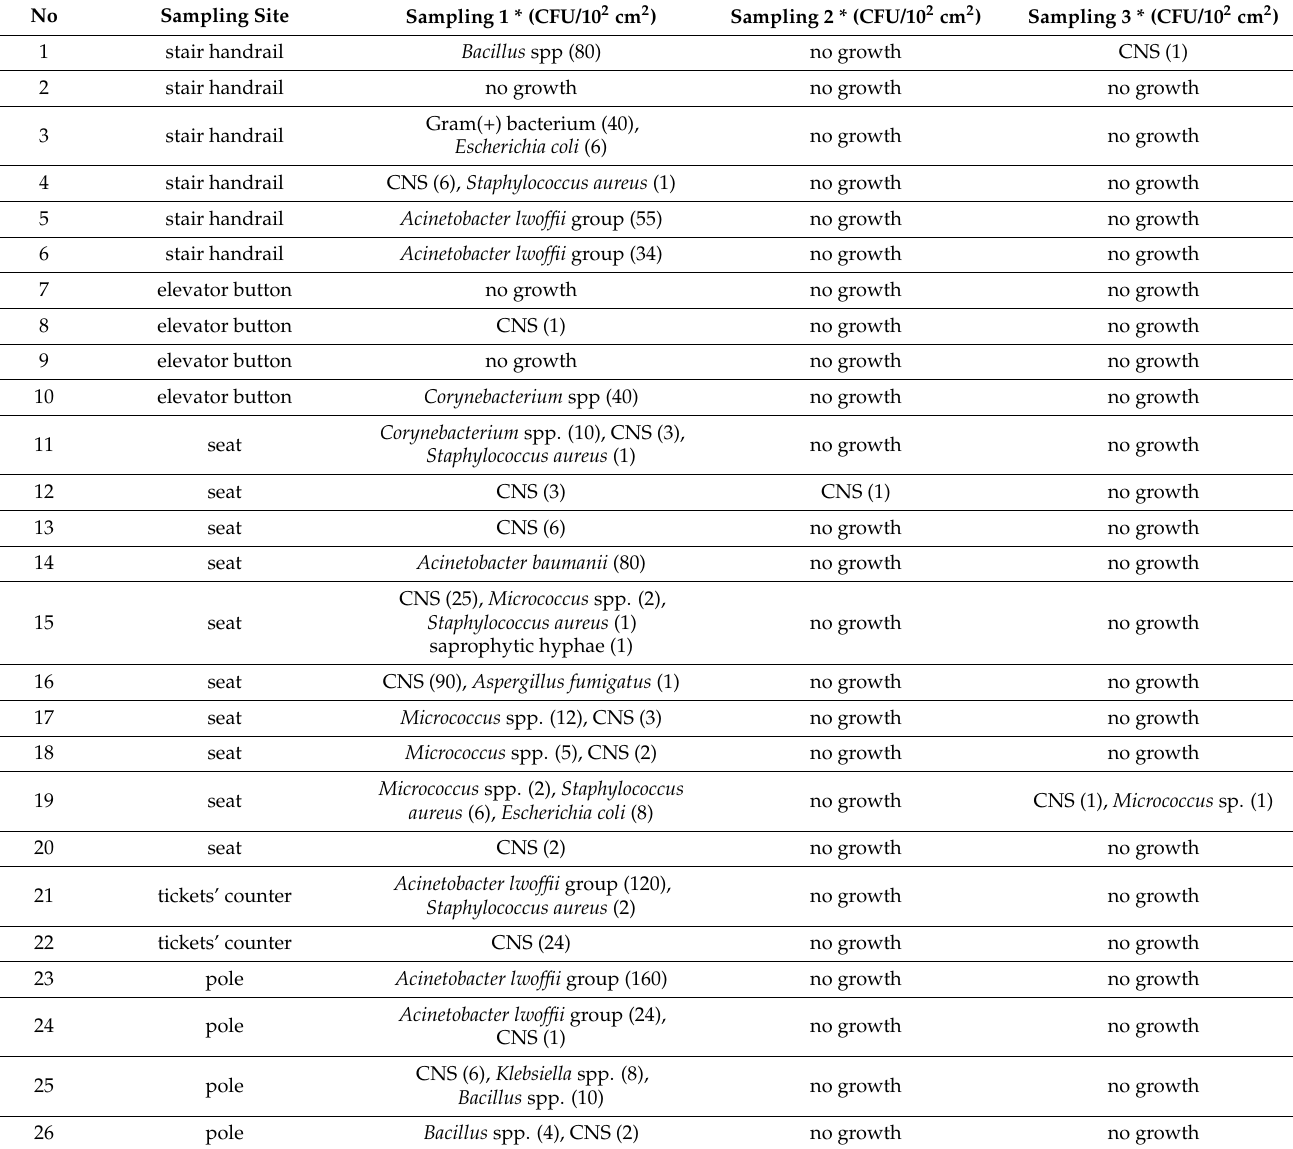
Table 4. Isolated bacteria and fungi by sampling site and time, Athens underground